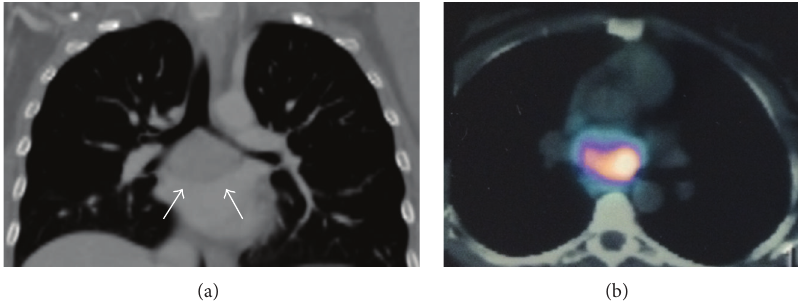
Figure 2: (a) Coronal view of chest computed tomography, revealing an intrapericardial 55 mm mass located at the roof of the left atrium (arrows). (b) 123 I-metaiodobenzylguanidine chest scan showing high uptake by the intrapericardial